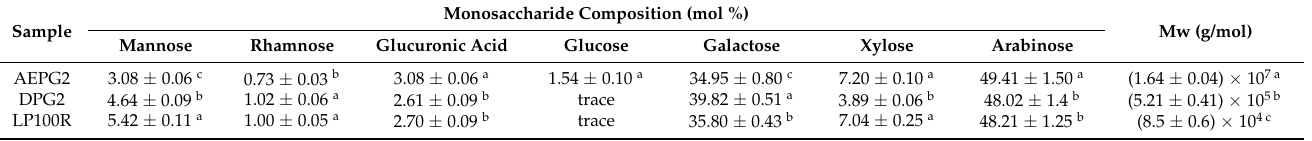
Table 1. Monosaccharide compositions and molecular weights of PGPs.